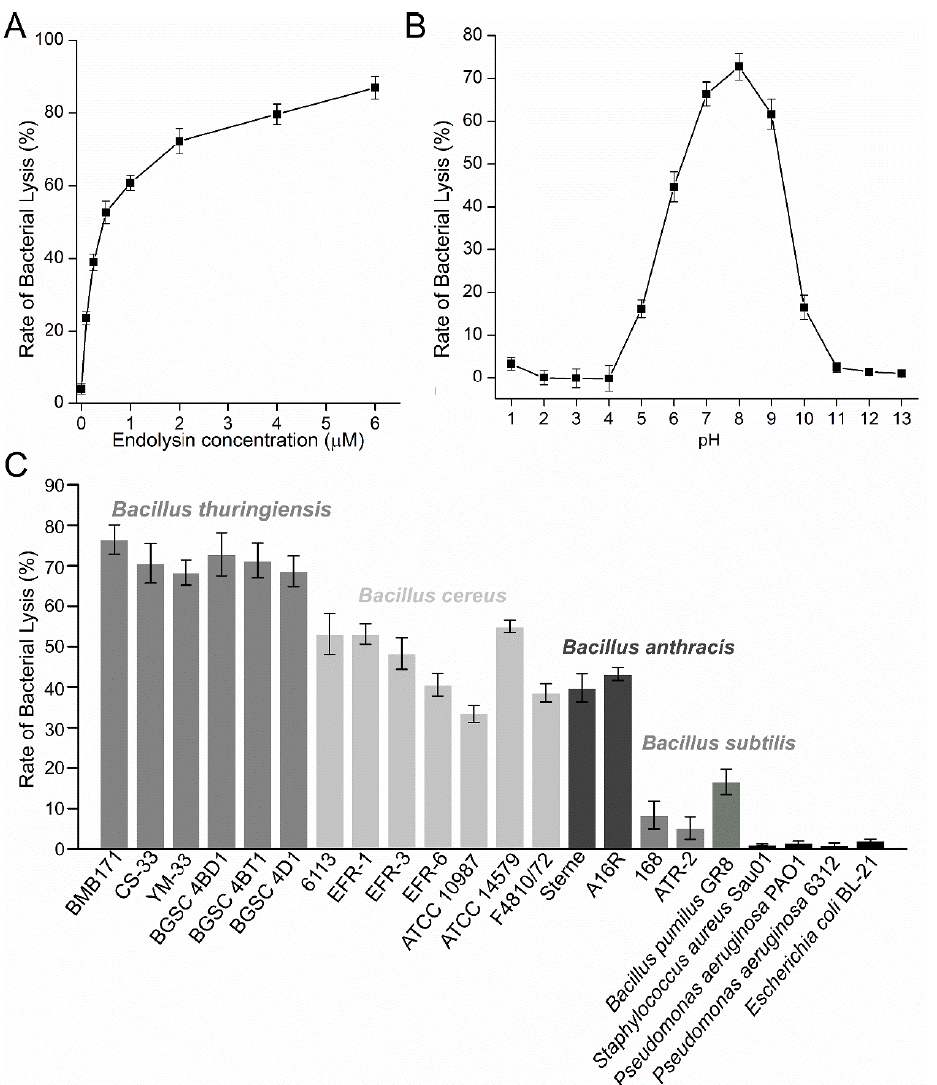
Figure 7. Lytic activity analysis of the endolysin PlyBMB. ( A ) The influence of concentration on the lytic activity of PlyBMB. ( B ) The influence of pH on the lytic activity of PlyBMB. The B. thuringiensis strain BMB171 was used for the optimal pH test. ( C ) Lytic spectrum of PlyBMB.